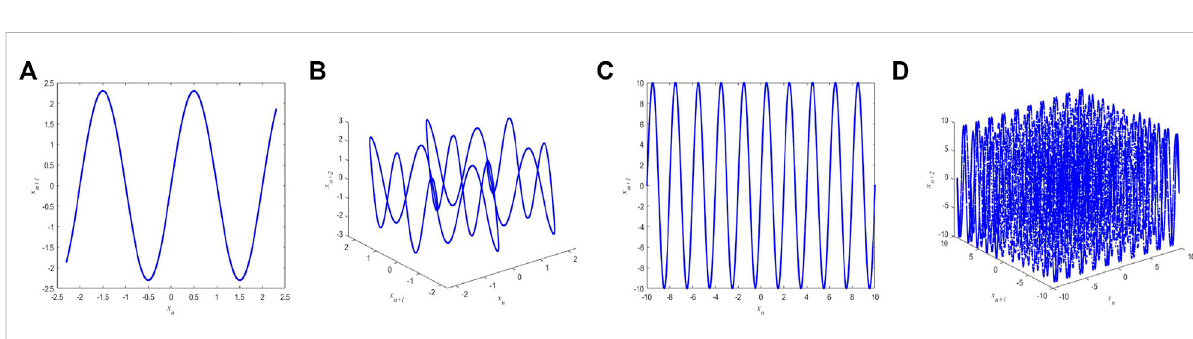
FIGURE 3 Trajectory analysis ofSinMap. (A) 2Dtrajectoryanalysis with φ =2.3. (B) 3Dtrajectory analysis with φ =2.3. (C) 2Dtrajectoryanalysiswith φ =10. (D) 3D trajectory analysis with φ =